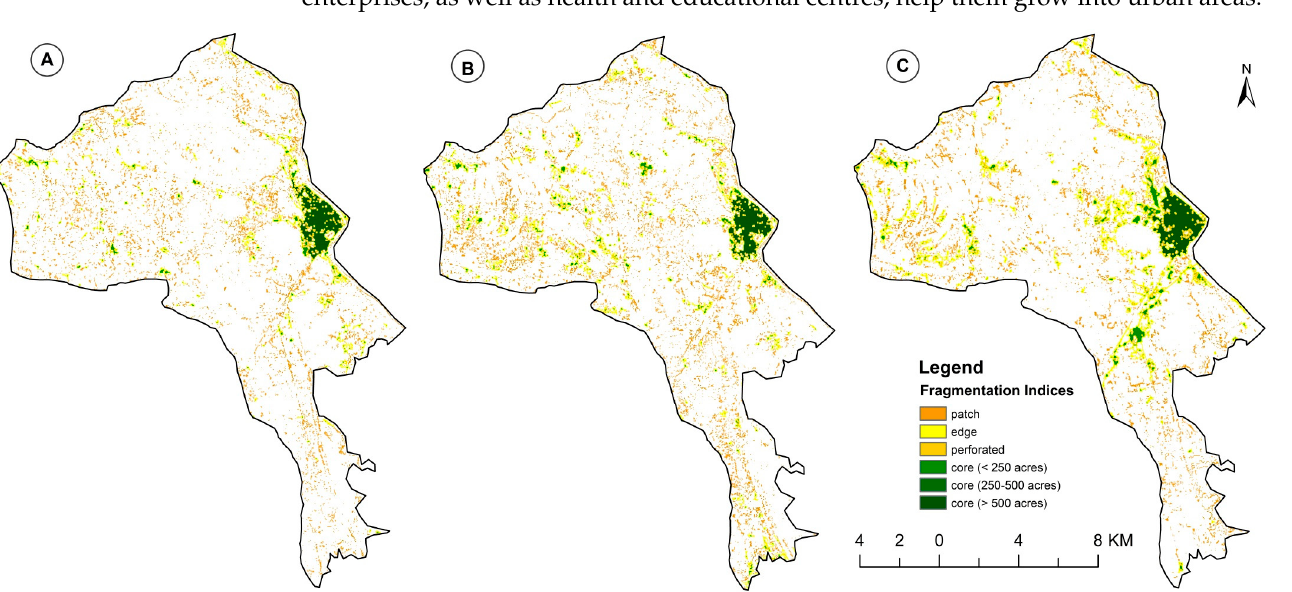
Figure 6. Built-up expansion process model using landscape fragmentation index for ( A ) 2001, ( B ) 2011, and ( C ) 2021 in English Bazar.